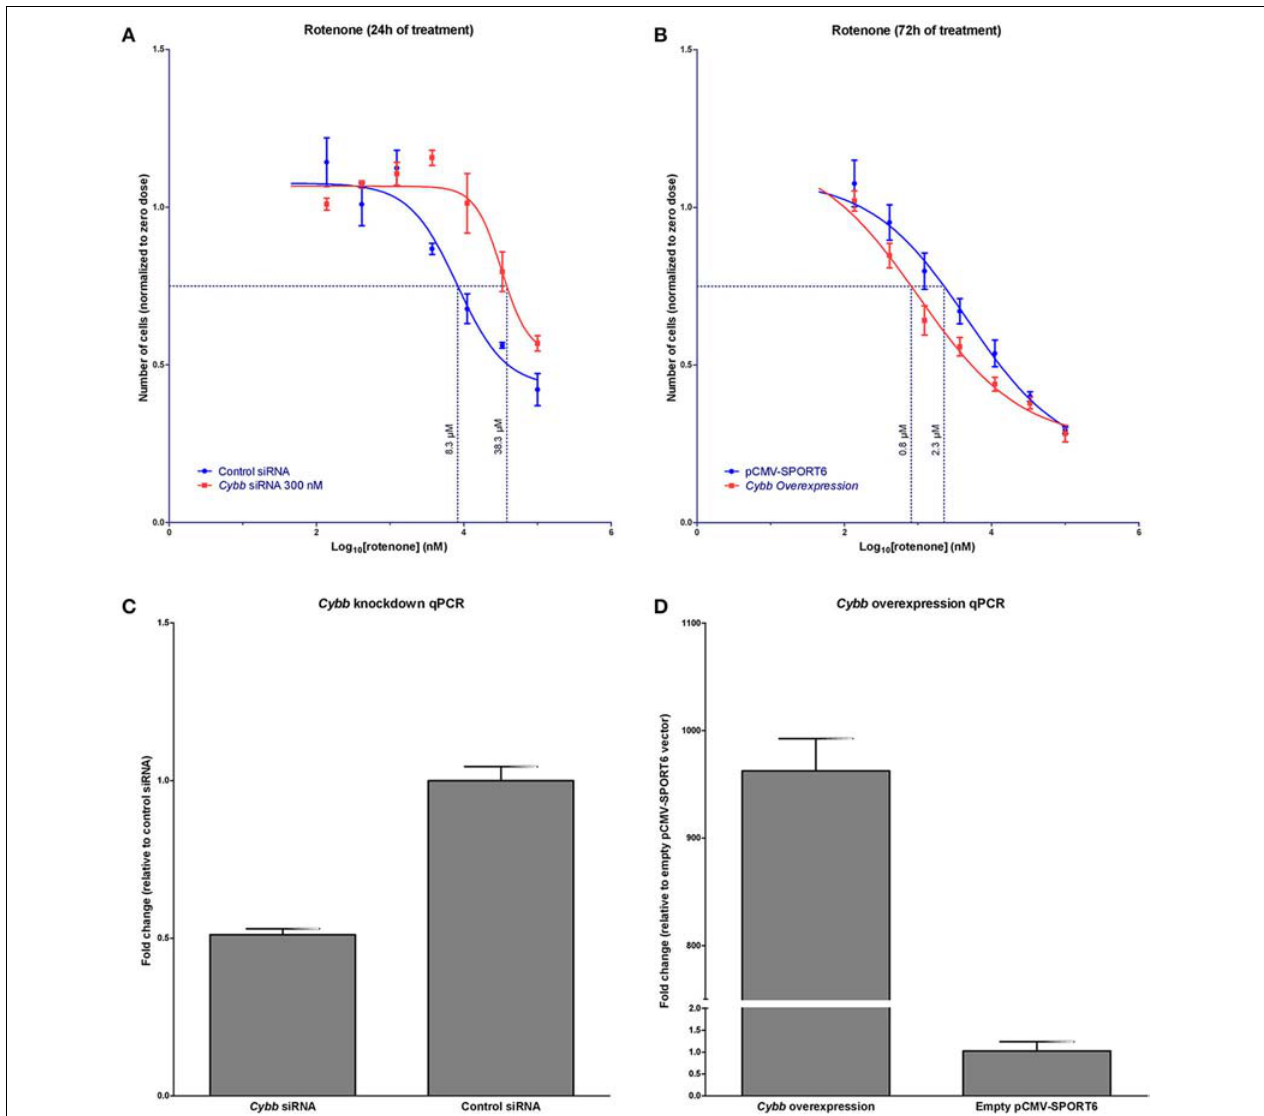
following Cybb over-expression ( n = 8 replicates at each concentration). Over-expression of Cybb shifts the concentration-response curve to the left. The dotted line shows the EC 75 . (C) Observed expression change in Cybb with siRNA knockdown ( n = 4 replicates), and (D) over-expression ( n = 2 replicates). Data are expressed as means ± SE